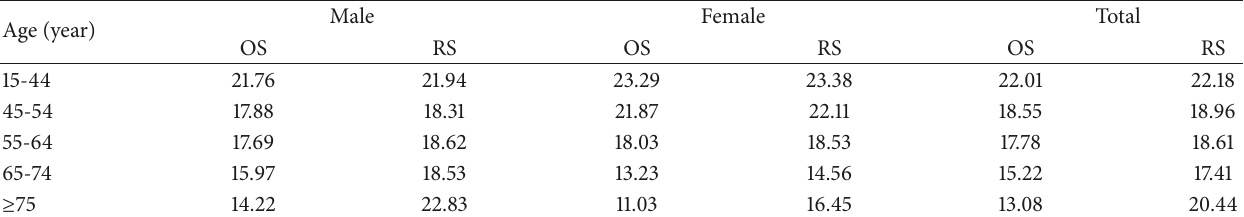
Table 4: The 5-year relative survival at age group in Zhejiang province from 2005 to